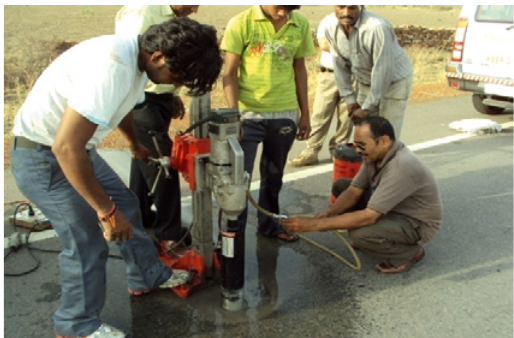
Figure 6. Full-depth core cutting of bituminous